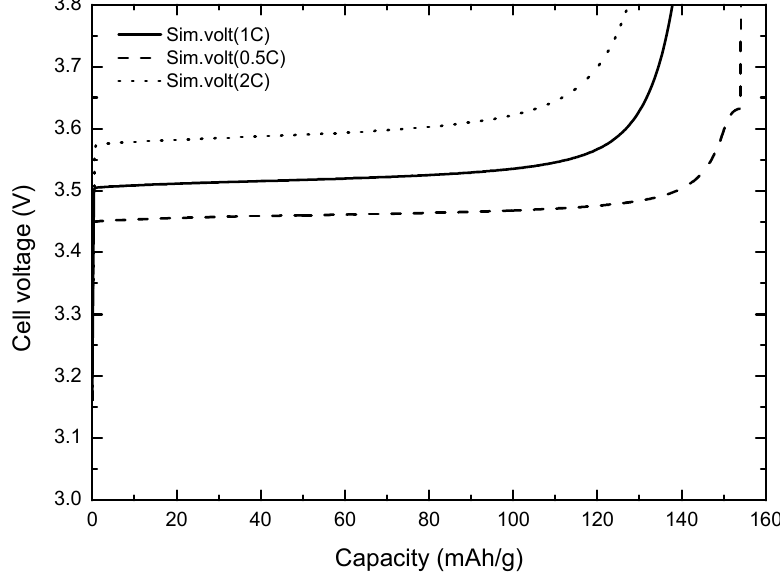
Figure 6. Voltage curves for charging at various C ‐ rates.